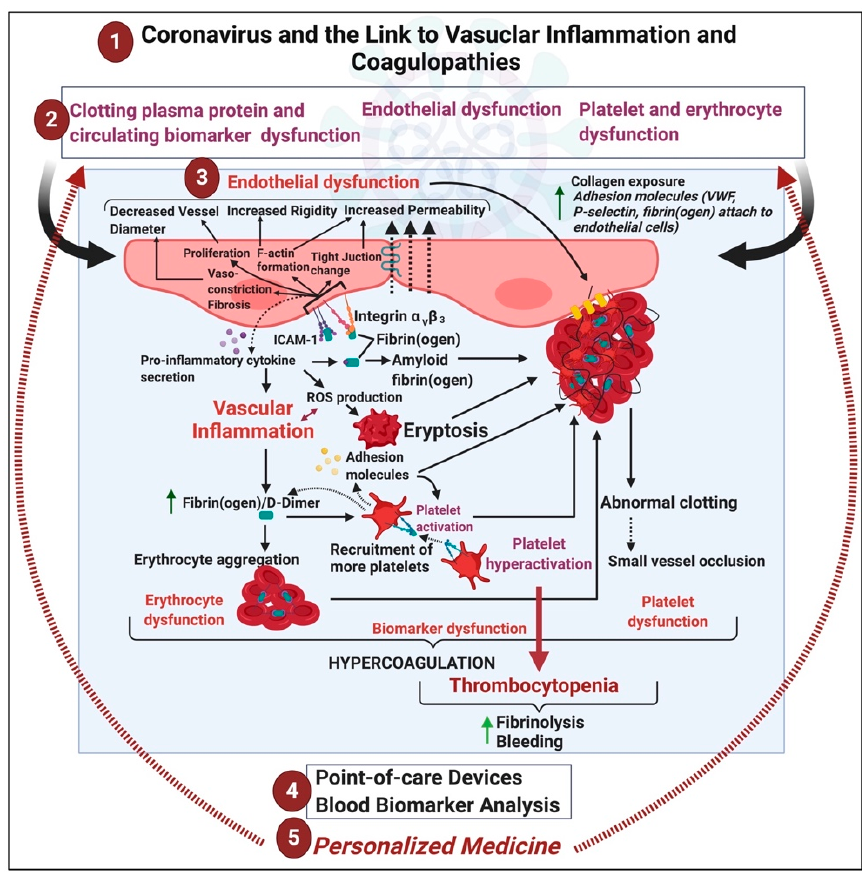
Figure 1. ( 1 ) Vascular implications of acute respiratory syndrome coronavirus 2 (COVID-19) ( 2 ) may result in clotting protein and circulating biomarker, endothelial, and erythrocyte and platelet dysfunctions. ( 3 ) We review the various biochemical processes associated with vascular dysfunction, focussing on fibrin(ogen), D-dimer, P-selectin and von Willebrand Factor. ( 4 ) We conclude by looking at point-of-care devices and methodologies in COVID-19 treatment and suggest that each patient should be treated using a ( 5 ) personalized medicine approach. This image was created with BioRender (https://biorender.com/).